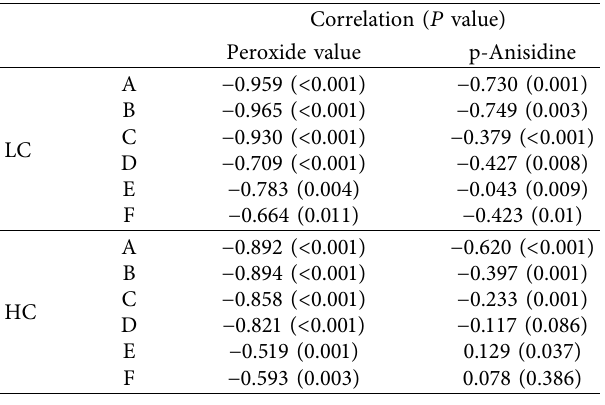
Table 3: Correlation coefficients ( P value) between vitamin D retention and oxidation products in different storage